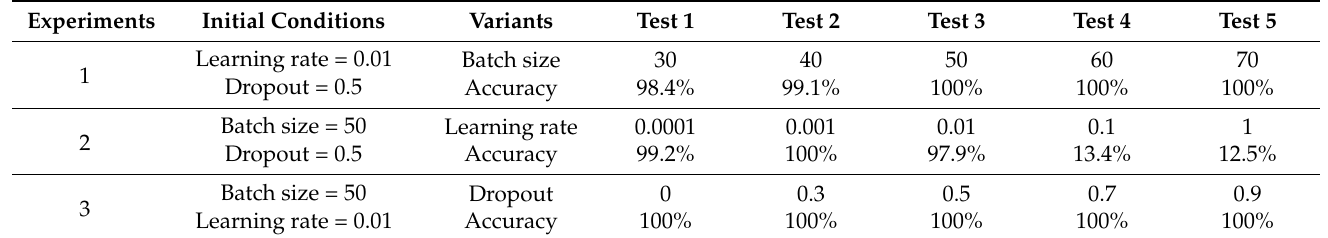
Table 4. Experiments for selection of optimal parameters using Dataset3.